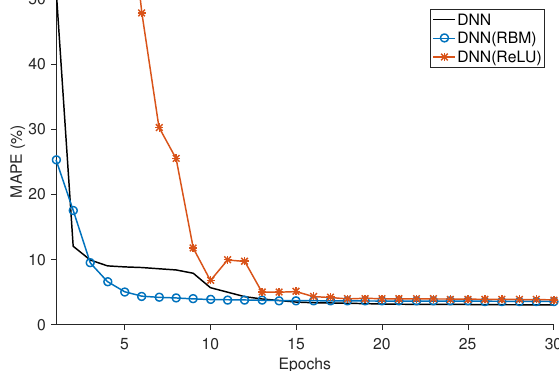
Figure 10. Training error comparison among DNN